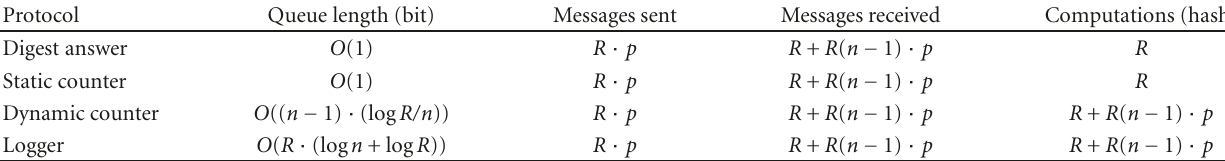
Table 3: Protocols comparison: